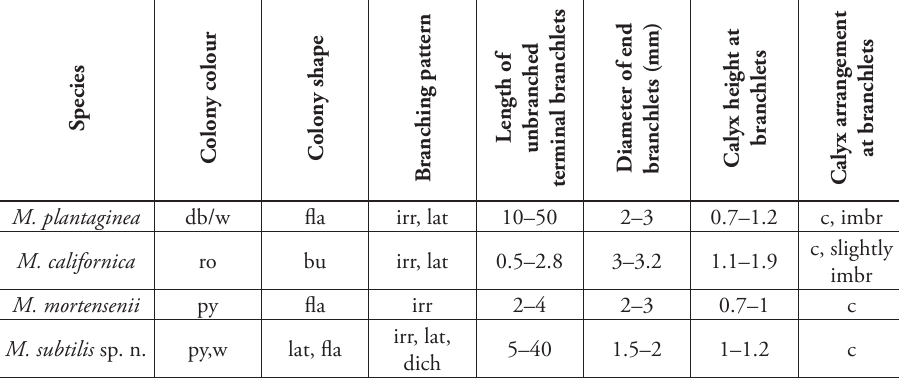
Colours: db, deep brown; py, pale yellow; ro, reddish orange; w, white, colourless. Colony shape: bu, bushy; fla, fan-like, flabelliform. Branching pattern: dich, irregularly dichotomous; irr, irregular; lat, lateral. Calyx arrangement at branchlets: c, close, not imbricate; imbr,